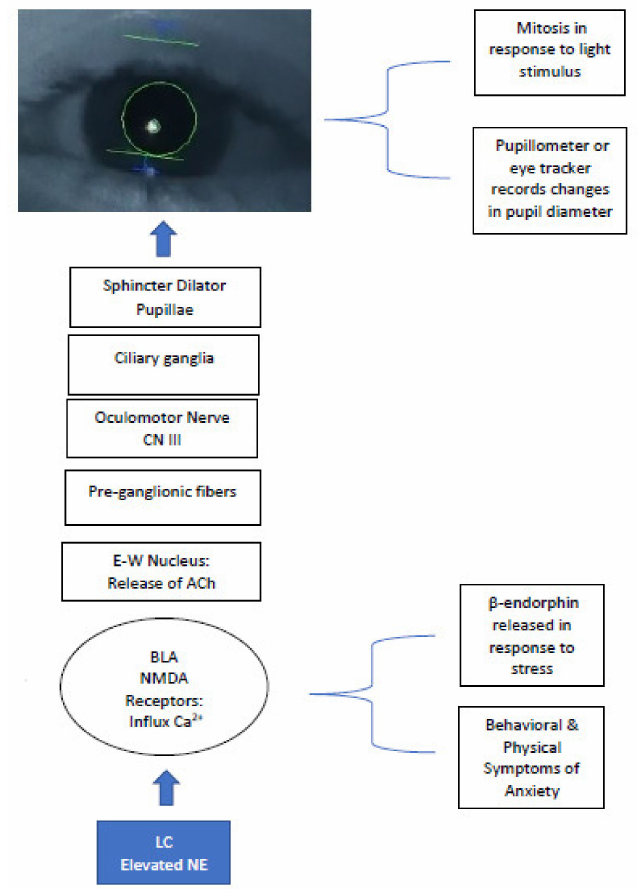
Figure 1. LC-NE system eliciting PLR and efferent visual neural pathway–modulation of NMDA receptors and cranial nerves produce pupillary change; elevated Ca 2+ at NMDA receptors increase NE levels = hyperarousal/sympathetic state in ASD, inducing sustained mydriasis in response to light stimuli. LC = locus coeruleus; NE = norepinephrine; BLA = basolateral amygdala; NMDA = N -methyl-D-aspartate; E-W = Edinger Westphal; ACh =